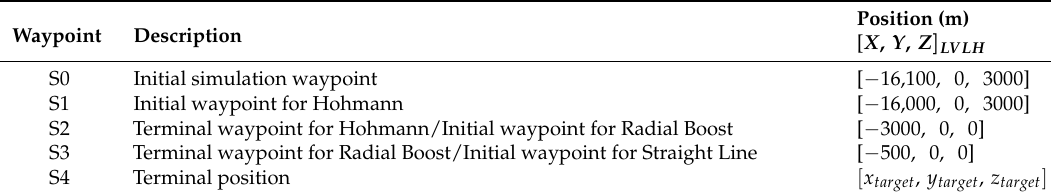
Table 2. Waypoint LVLH position.